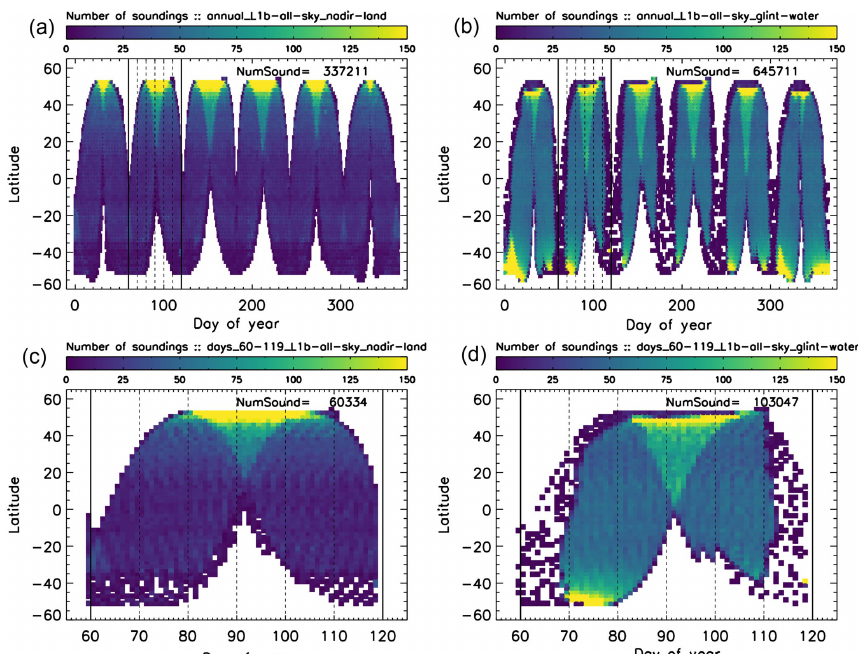
Figure 2. Simulated sounding densities for nadir–land (a, c) and glint–water (b, d) for the annual (a, b) and DOY 60–119 (c, d) datasets. Data are binned in 1d by 2 ◦ latitude increments. Values should be inflated by 240 to reflect real expected sounding densities at the full spatial (eight footprints per frame) and temporal (3Hz) acquisition rates. To account for the large dynamic range, the density scale has been truncated at 150, although the extreme high latitudes contain up to 300 soundings per bin in some